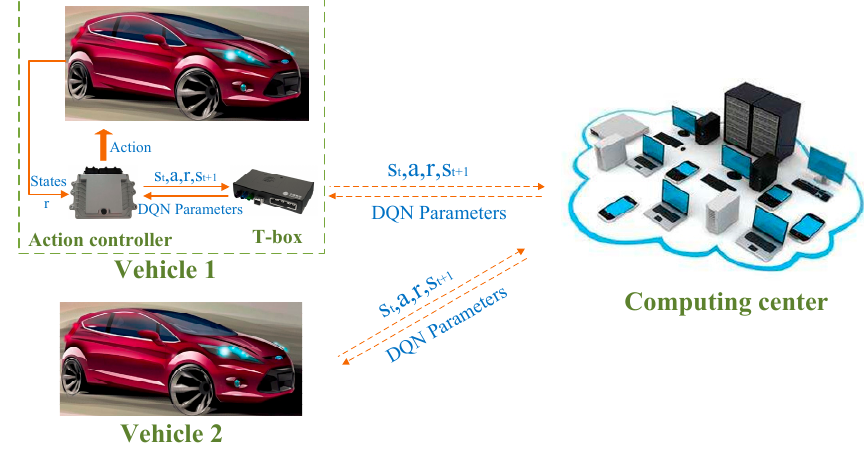
Figure 4. DRL-based online learning architecture.